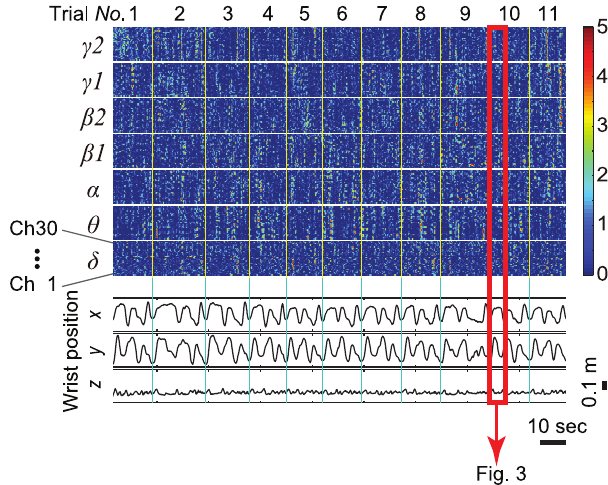
Figure 4. Color-map of the normalized ECoG signals and coordinates at the left wrist joint. Signals were obtained from channels 1 , 30 in session 2 of patient 1(channels 31 , 60 are not shown). This session includes 11 cycles. We treated each cycle as an independent trial.Start and end points were respectively defined as the instances where tangential velocity of the arm exceeded or fell below 5% of maximum velocity. Unused sampling points are colored yellow (yellow vertical lines). Precise wave forms of z -score on channel 27 inside of a red rectangle were already displayed in detail in Figure 3.